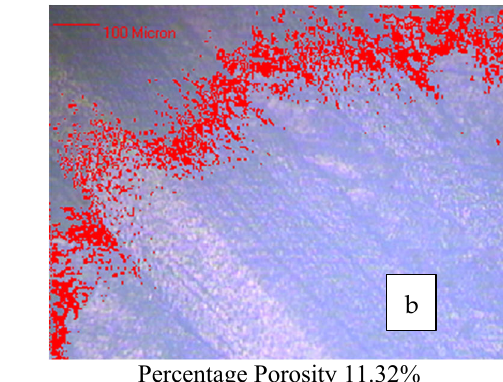
Figure 14. Porosity analysis for ( a ) sample 4 (ATA material specimen) and ( b ) sample 14 (TAT material specimen).